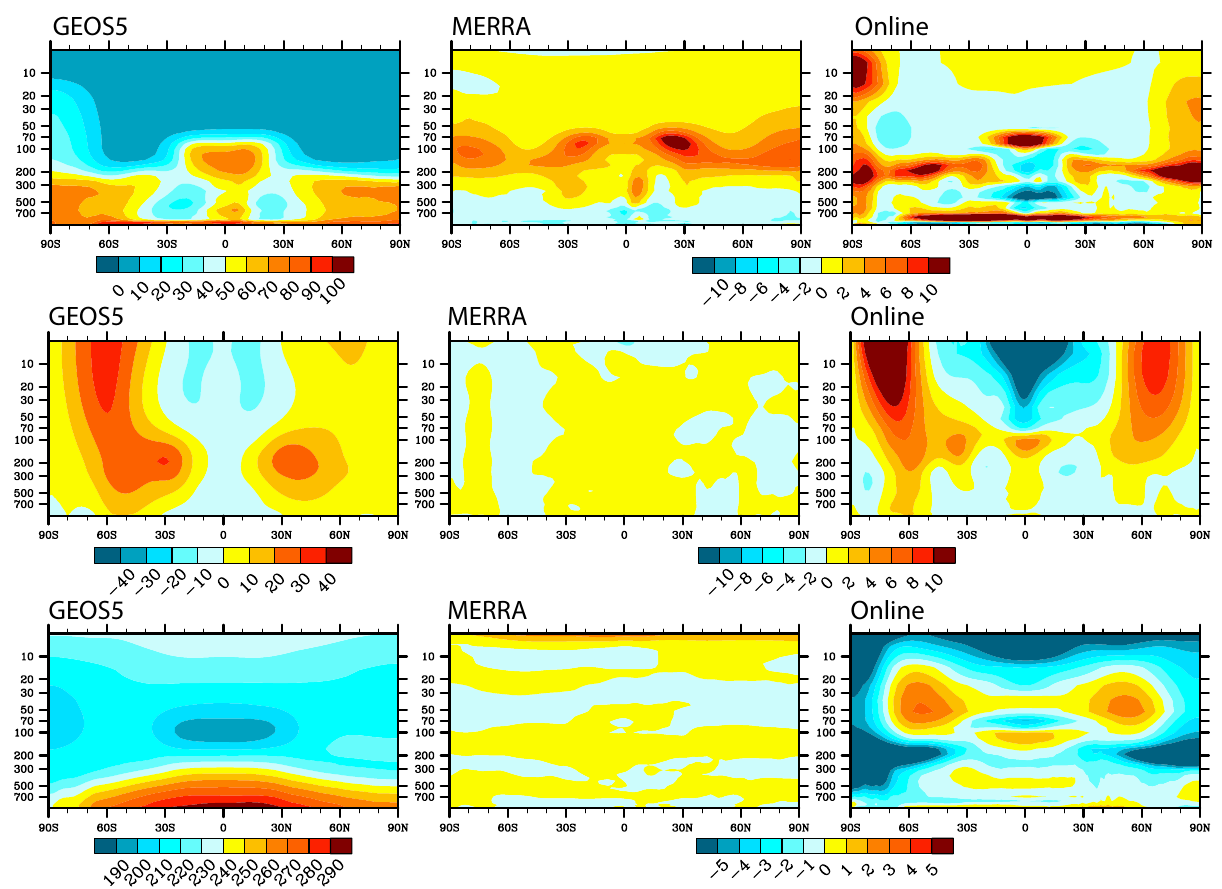
Fig. 4a. Annual (2006–2008) and zonal mean distribution of relative humidity (top, %), zonal wind (middle, ms − 1 ) and temperature (bottom, K) in GEOS5, MERRA and the online configurations (shown as absolute difference with respect to GEOS5, note different color